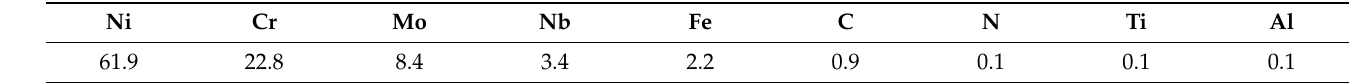
Table 1. Inconel 625 chemical composition (mass fraction, %).